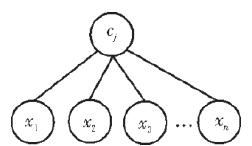
Figure 4. Plain Bayesian theory